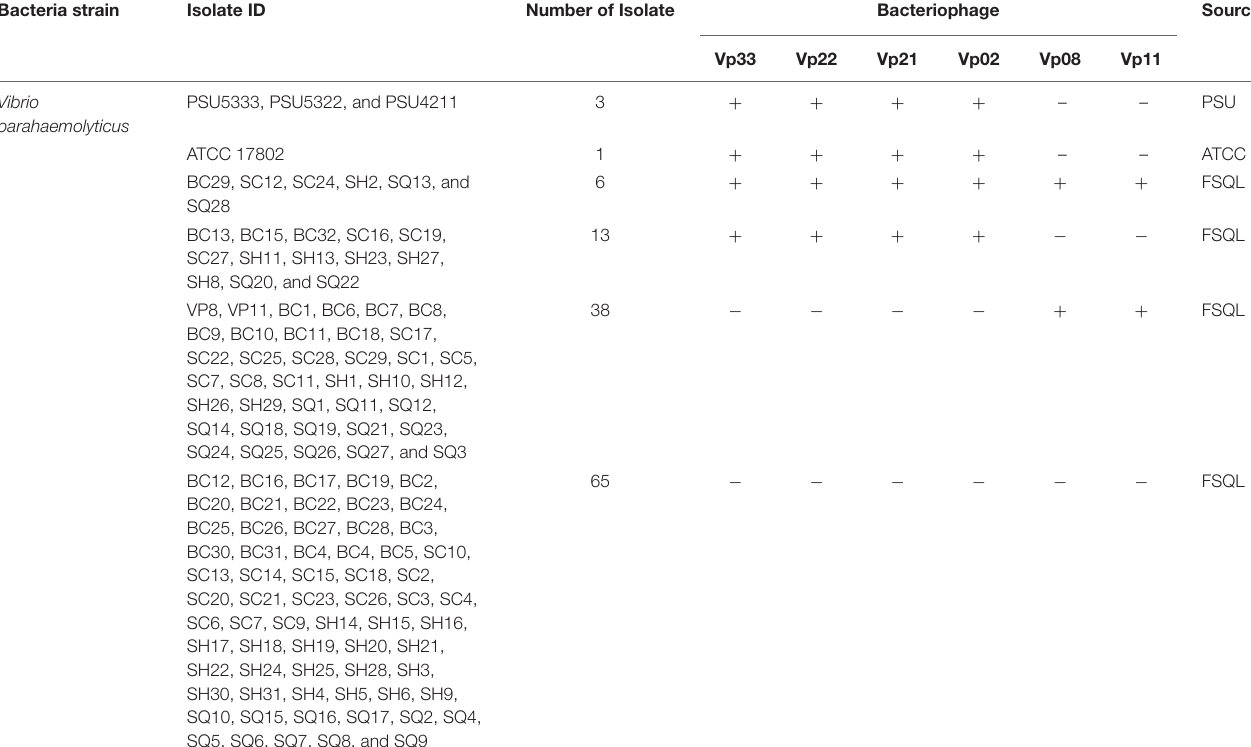
TABLE 3 | Host range specificity on different V. parahaemolyticus